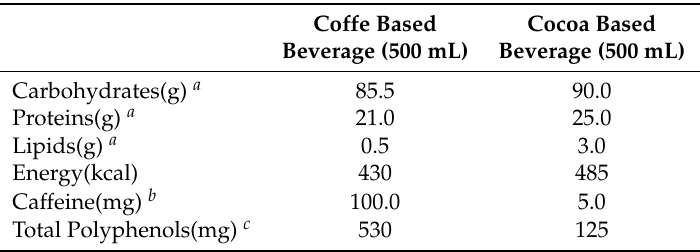
Table 1. Nutrient composition and bioactive compounds of beverages formulated for post-workout